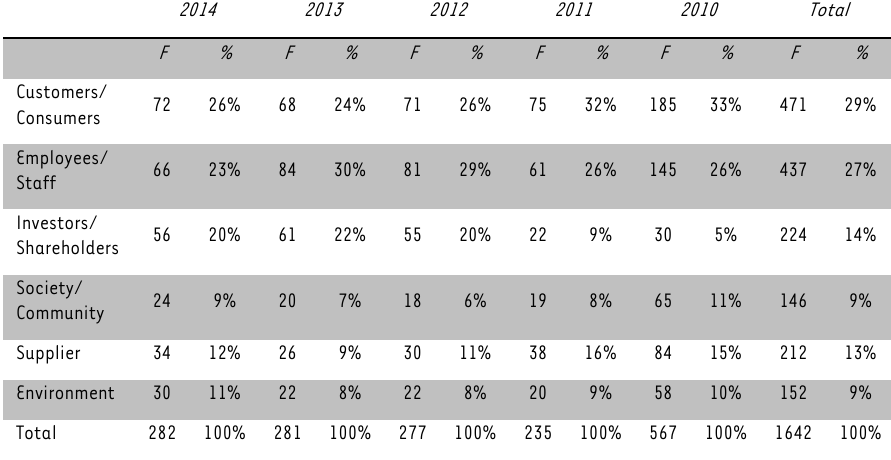
TABLE 11: Shoprite Stakeholder frequencies from 2010 to 2014